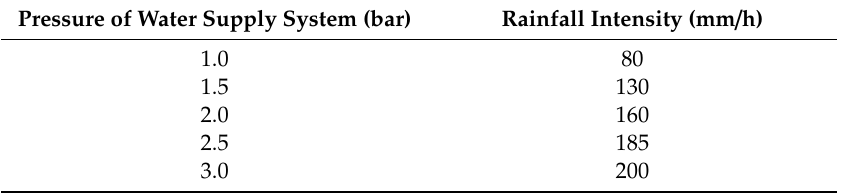
Table 1. Rainfall intensity change according to manipulated pressure of the water supply